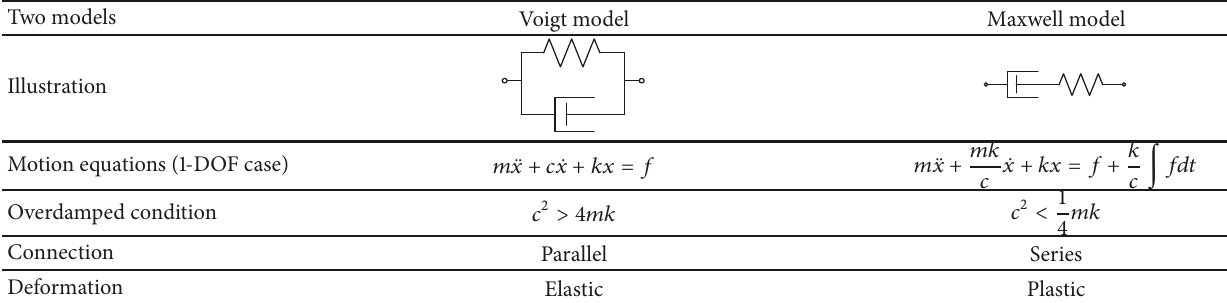
Table 1: Two viscoelastic